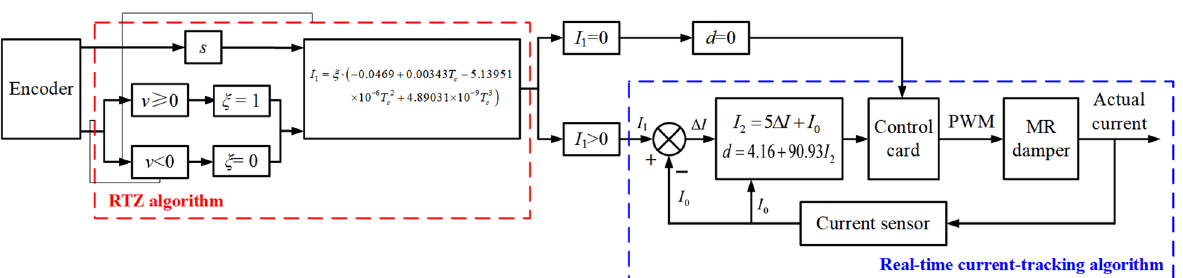
Figure 9 Design process of the